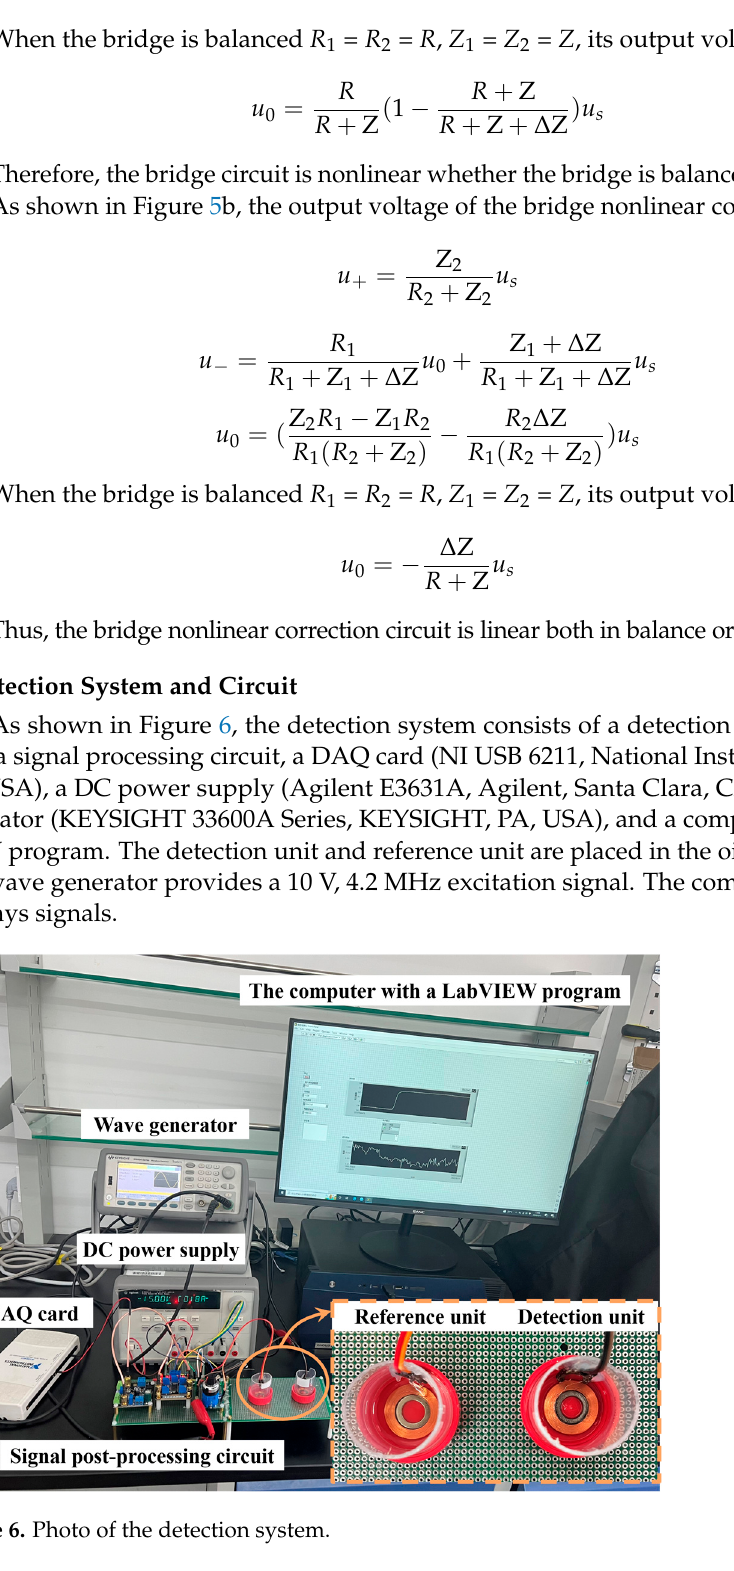
Figure 7. Schematic diagram of signal processing circuit. 4. Experiment and Discussion In the experiment, due to the distribution of wires and craftsmanship of components, it is impossible to guarantee that R 1 = R 2 = R , Z 1 = Z 2 = Z . This means that when ∆ Z = 0, there is a certain base voltage that will be amplified in the signal post ‐ processing circuit causing the useful signal to be drowned out. By replacing R 2 with a precision adjustable resistor and adjusting the frequency of excitation voltage, the base voltage can be minimized. At the same time, the frequency of excitation voltage also affects the sensitivity of the sensor. Considering the base voltage and sensor sensitivity, the precision adjustable resistor R 2 , and excitation voltage frequency are adjusted. Finally, the excitation voltage frequency is determined to be 4.2 MHz. 4.1. Void Test